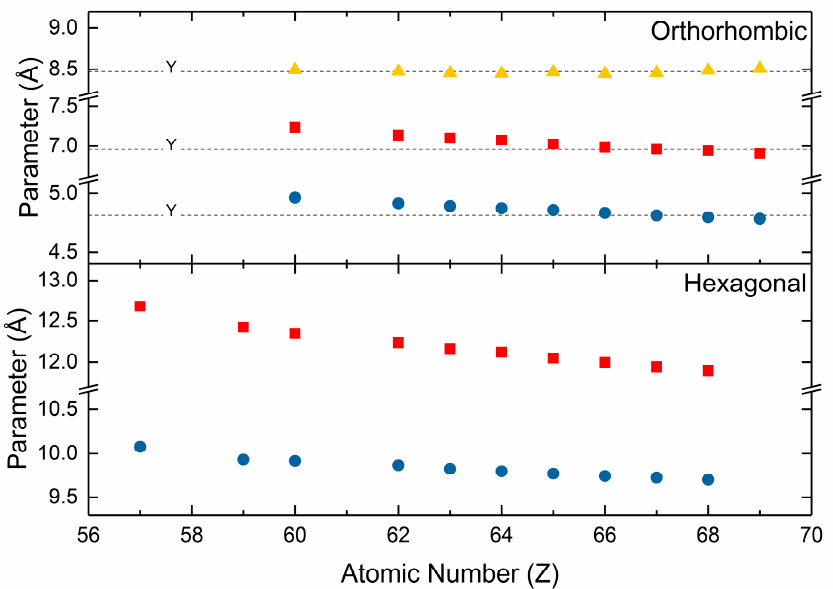
Figure 6. Lattice parameters for the orthorhombic and hexagonal rare earth hydroxycarbonates. Values for the orthorhombic hydroxycarbonates are from Tahara [124]. Values for the hexagonal hydroxycarbonates are from Michiba [79].